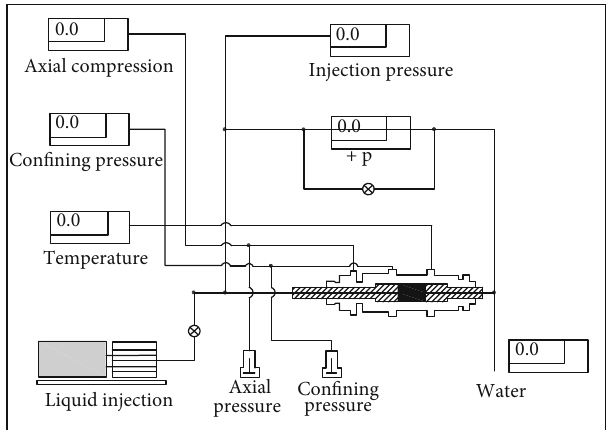
Figure 2: A schematic image of the seepage experimental system.